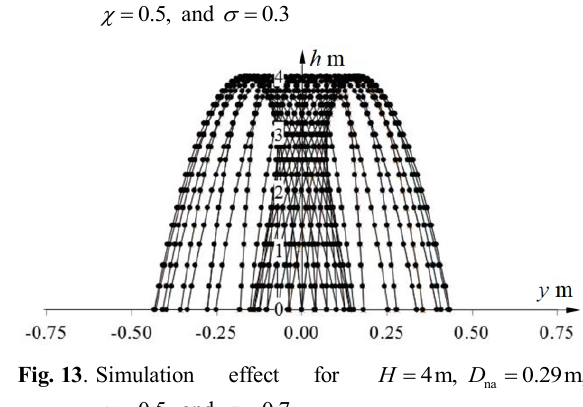
Fig. 12 . Simulation